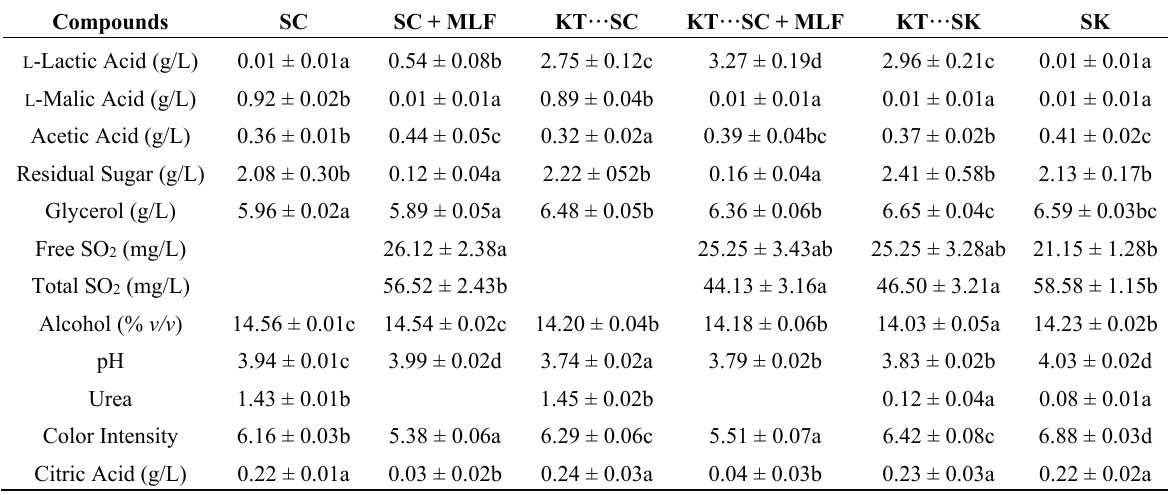
Table 1. Final analysis of Saccharomyces cerevisiae 87 by itself (SC), sequential fermentation with Saccharomyces cerevisiae 87 and Kluyveromyces